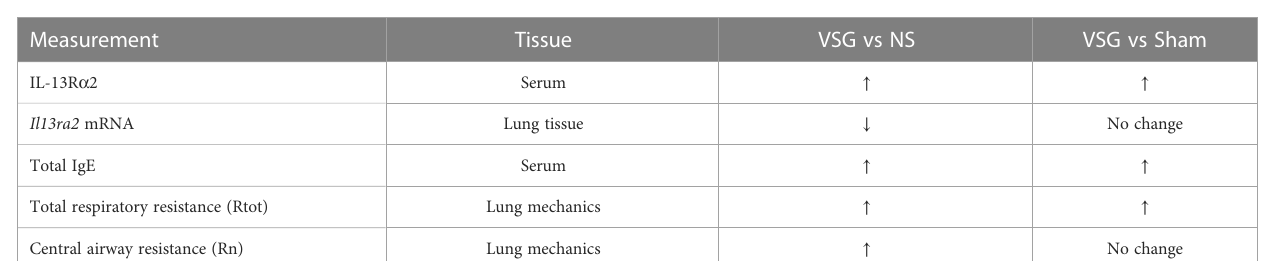
TABLE 1 Summary of Findings.